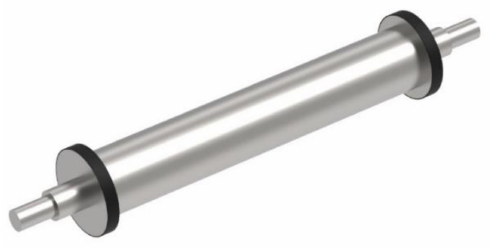
Figure 20. Idler shaft